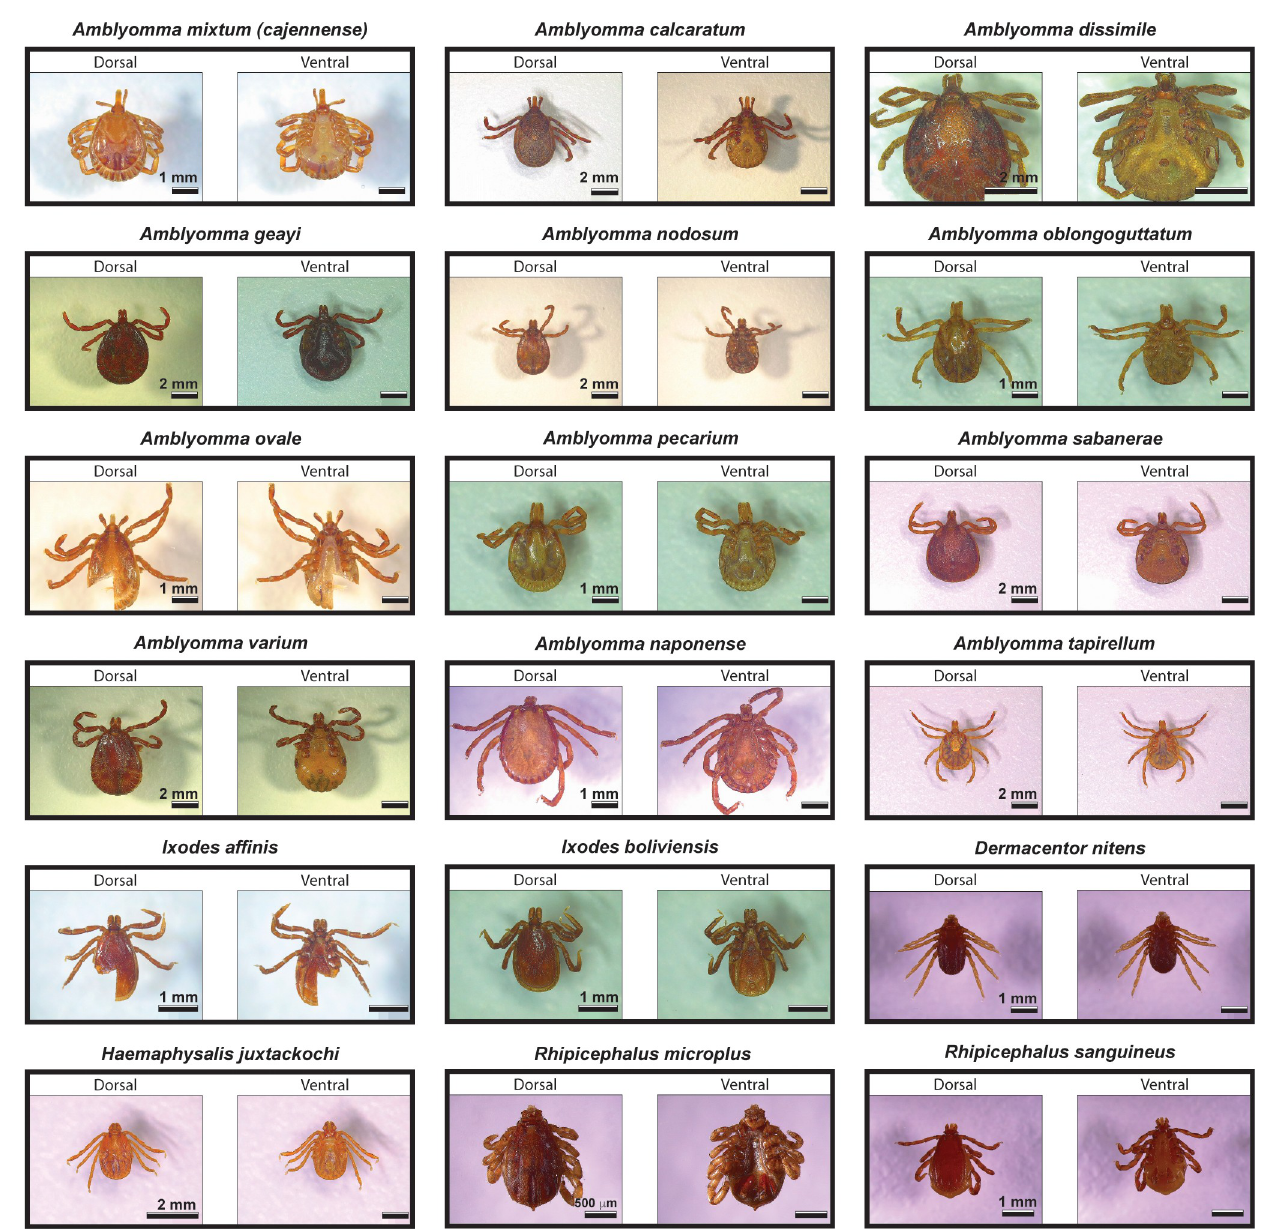
Fig 1. Optical micrographs of Neotropical hard ticks. The image shows the dorsal and ventral sides for all 18 species of hard ticks in the